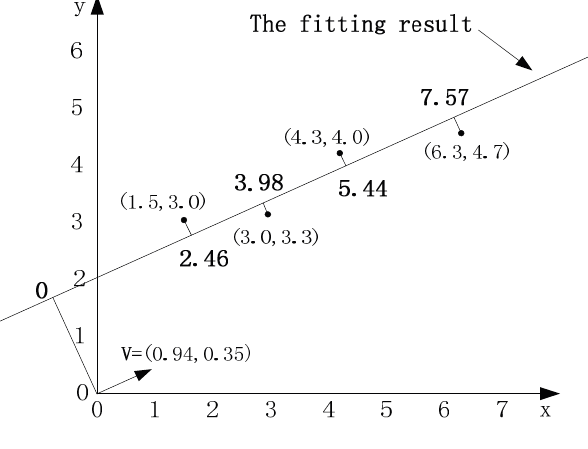
Figure 5. An example of fitting the